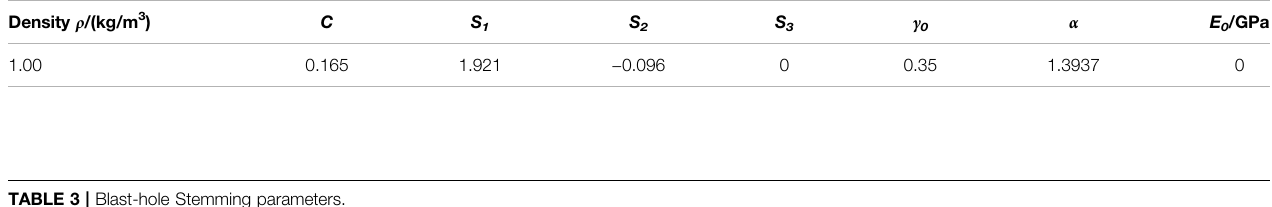
TABLE 2 | Water material model and state equation parameters.